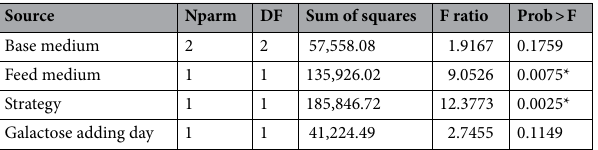
Table 1. Statistical analysis of four factors effecting on productivity using titer value as the response. * Significant when P is less than